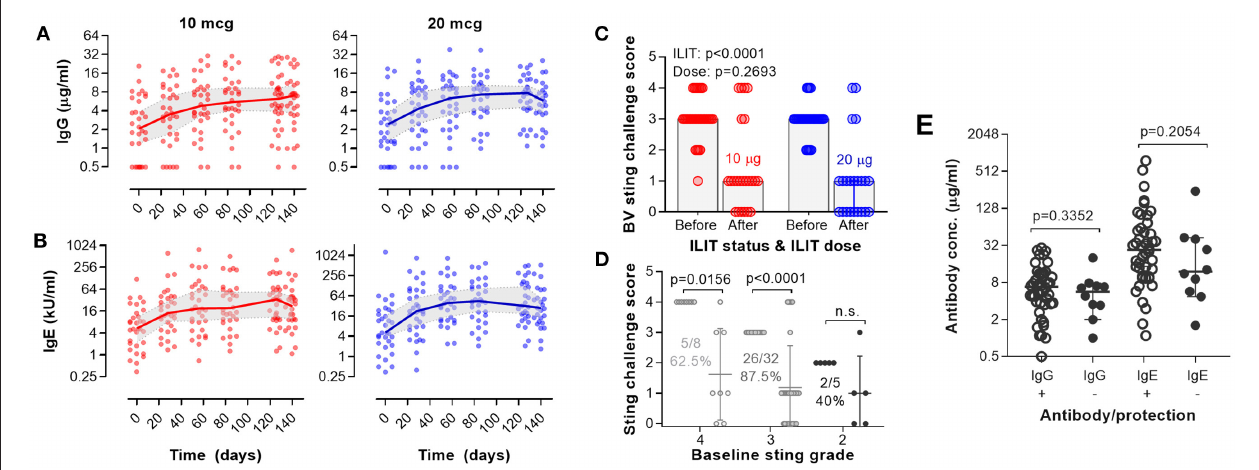
FIGURE 4 | Assessment of antibody responses and honeybee sting provocation test after bee venom ILIT. Study subjects were treated with 10- (red) or 20- µ g (blue) bee venom allergen extract, and allergen-specific IgG (A) and IgE (B) were analyzed by SPRIA (IgG) or ImmunoCAP (IgE). The red and blue lines show the median antibody concentration, and the gray-filled area show the 95% confidential interval of the median. (C) After completed ILIT, 45 study participants were subject to a honeybee sting challenge. The challenge was done at screening as well as 8 weeks after the last bee venom allergen ILIT with 10-(red) and 20- µ g (blue) BeeAlleVax TM . The sting reactions were scored and the effect of ILIT and dose were analyzed statistically using a mixed-effects model. (D) Per-protocol analysis of the combined sting challenge data as a function of sting grading at baseline. (E) Based on the sting reactions, patients were segregated into protected ( n = 35) and non-protected ( n = 10) patients, and the IgG or IgE concentrations measured in serum at the time of the challenge (day 140) were assigned to the protected or non-protected patients. The antibody levels were then compared by the Mann–Whitney U test for a statistical